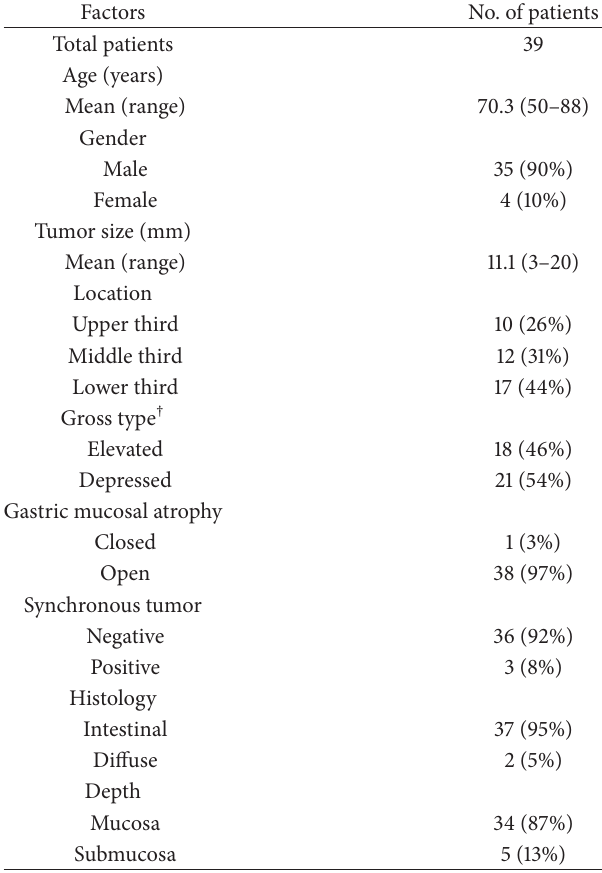
Table 1: Clinicopathologic characteristics associated with metach- ronous gastric